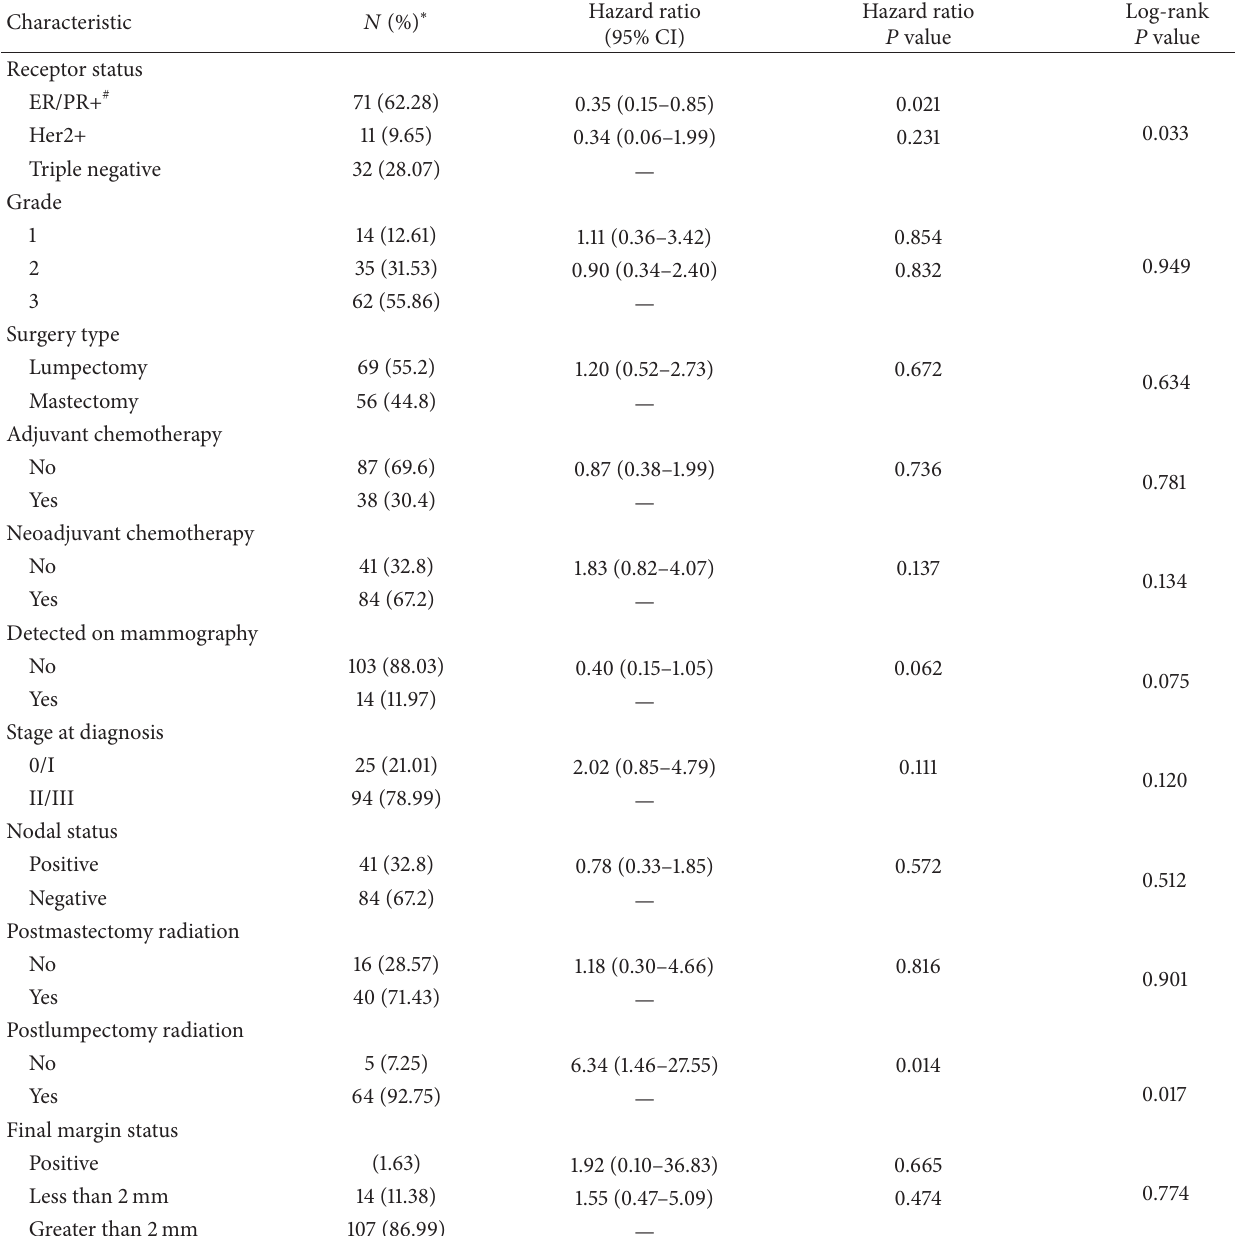
Table 2: Univariate analysis of risk factors for locoregional free survival in younger women.